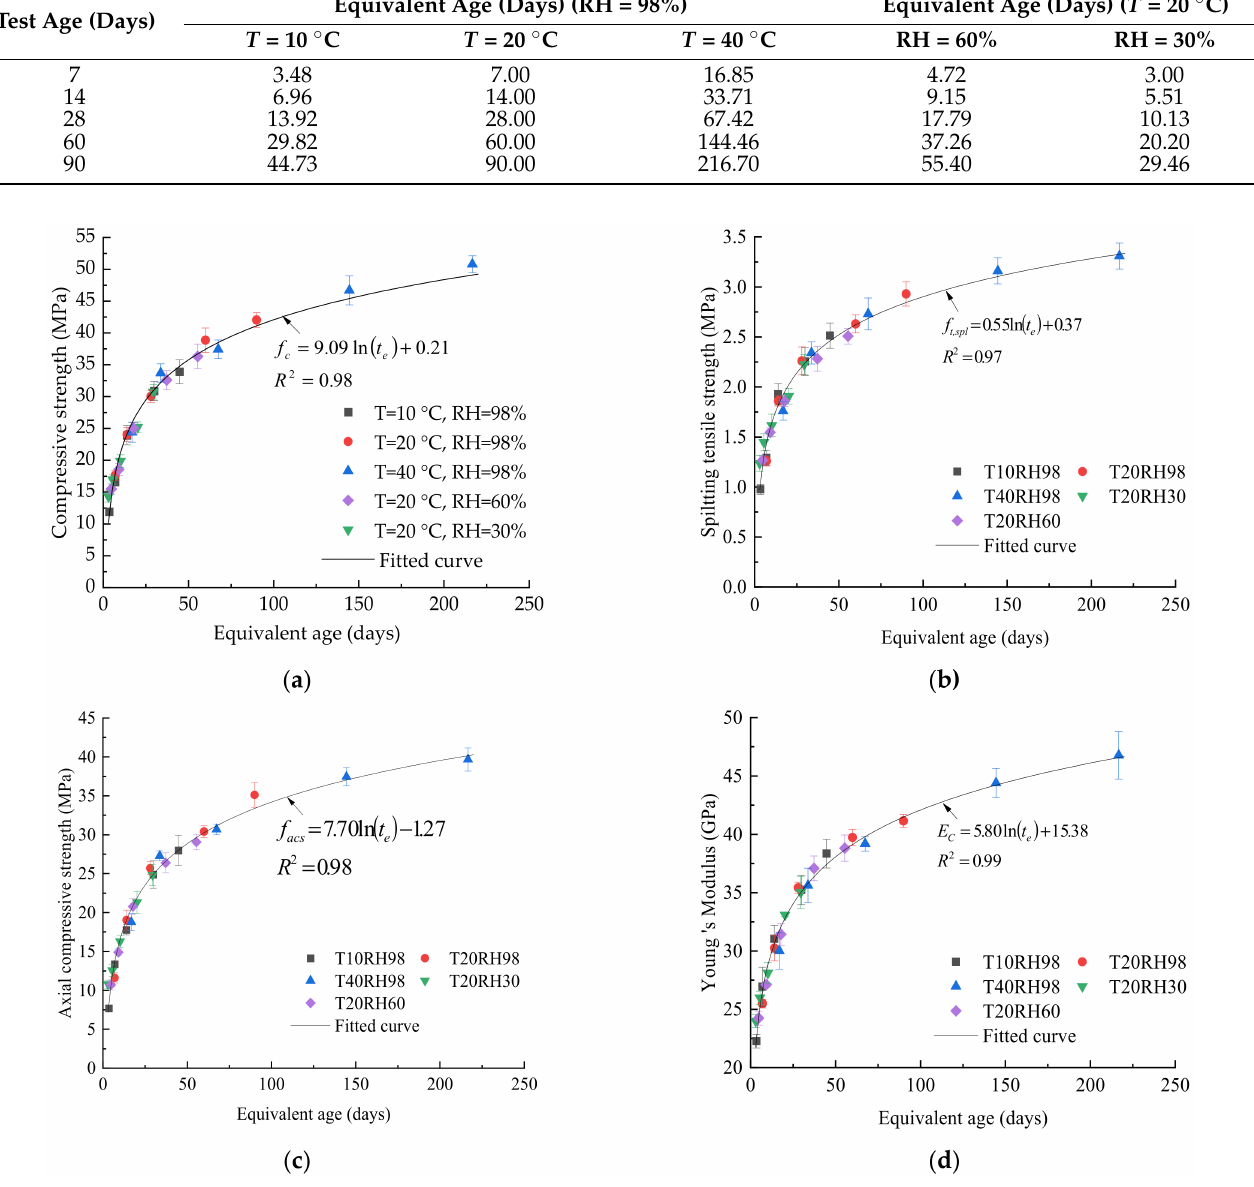
Figure 13. Relationship between strength parameters and equivalent age: ( a ) compressive strength; ( b ) splitting tensile strength; ( c ) axial compressive strength and ( d ) static compressive elastic